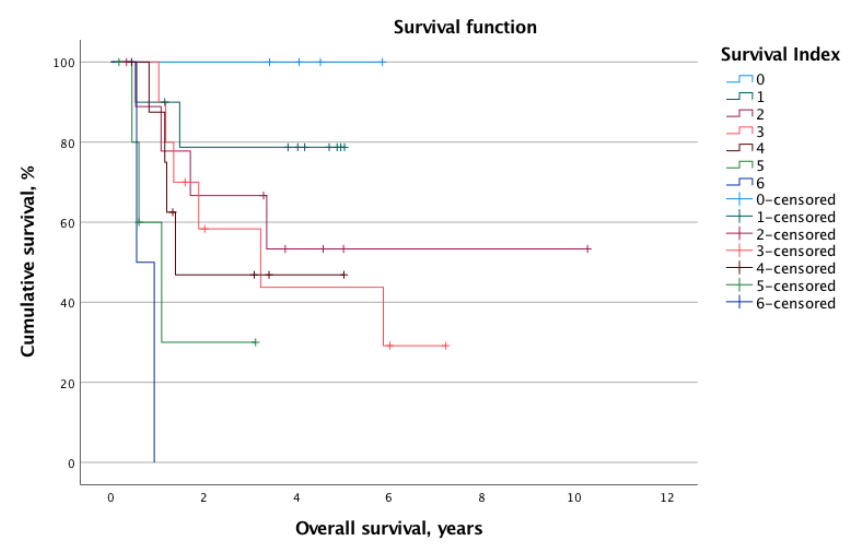
Figure 3. When stratified for the exact survival index score (0–6), the Kaplan–Meier survival curve shows a significant association between rising survival index and worse overall survival ( p < 0.001).